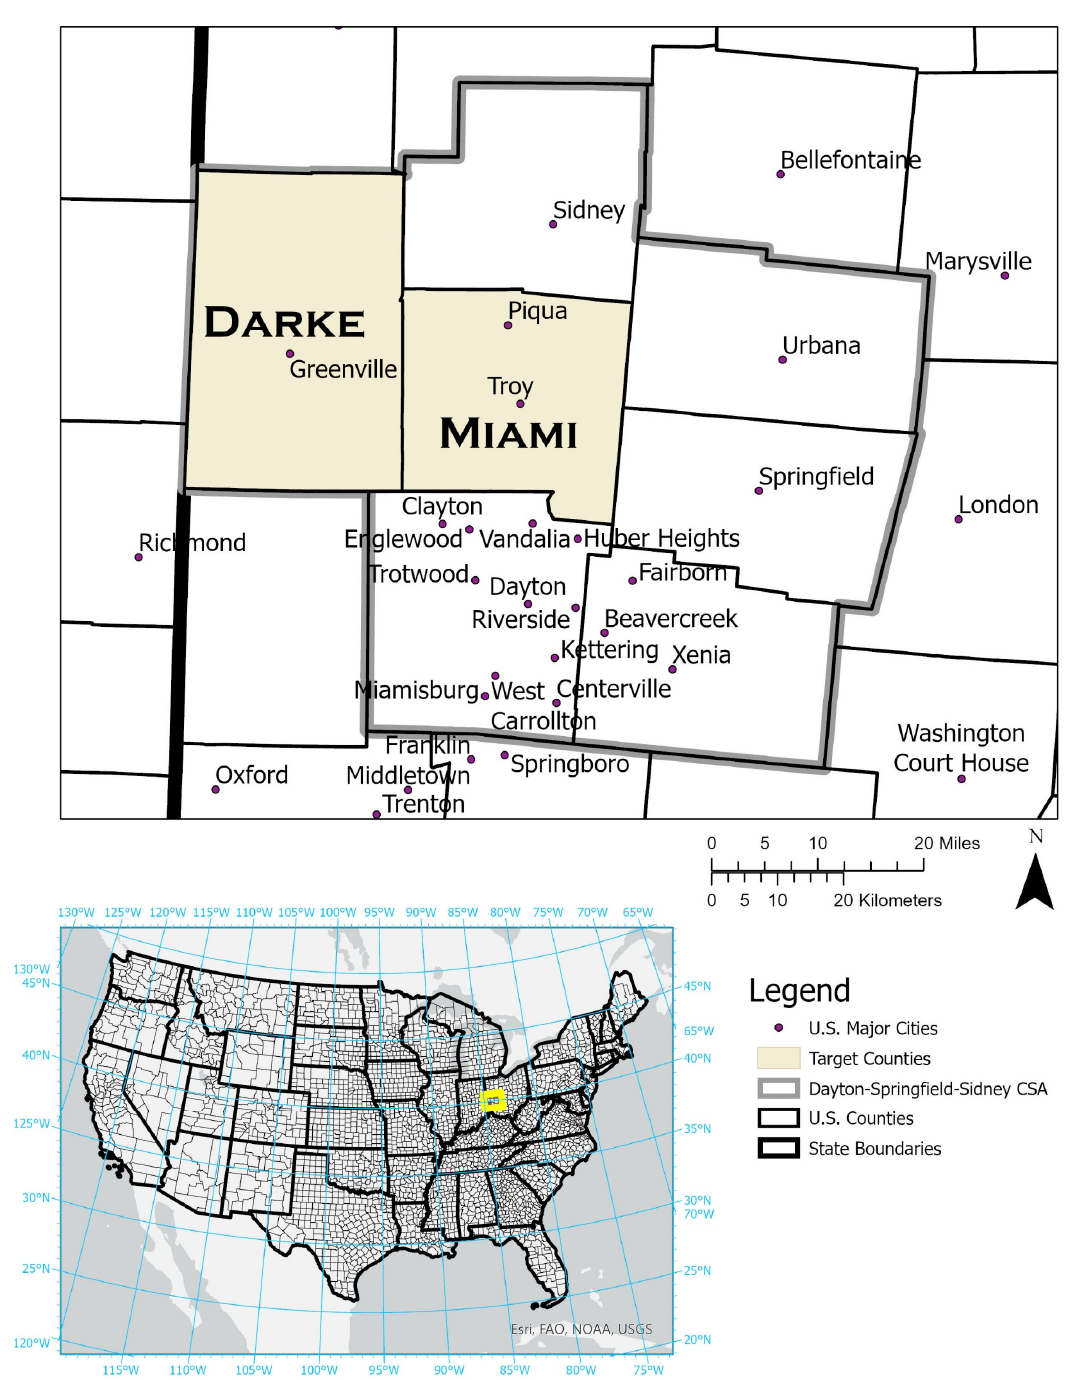
Figure 1. Study area. Study area map displaying the two counties (Darke and Miami counties in Ohio, U.S.A) from which single-family homes were randomly selected. Additionally, shown are states for the conterminous U.S.A. and the Dayton-Springfield-Sidney Combined Statistical Area (CSA) as designated by the United States Census Bureau, as well as cities in the U.S.A. with more than 10,000 inhabitants. The yellow box in the lower map shows the location of the study region with respect to the United States of America (and within the State of